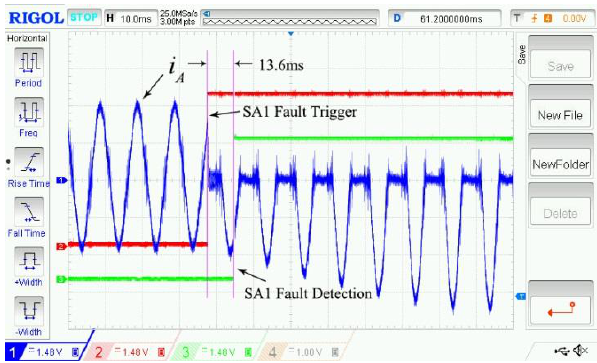
Figure 14. Input current and SA1 fault trigger and detection signals of phase A.